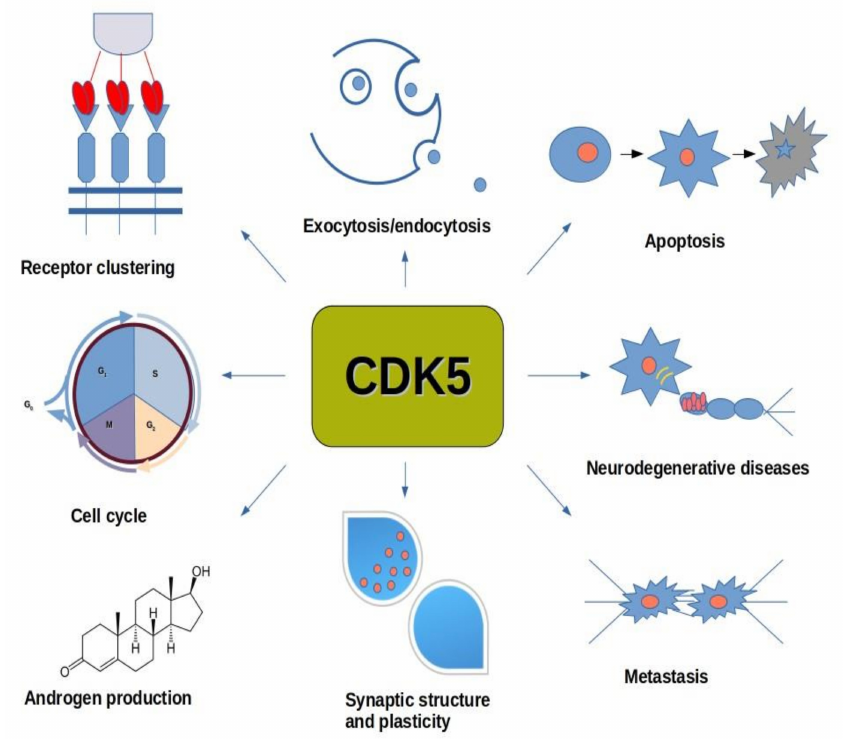
Figure 1. Simplified schematic of the regulation of cyclin-dependent kinase (CDK)5 activity. Involve- ment of CDK5 in various biological